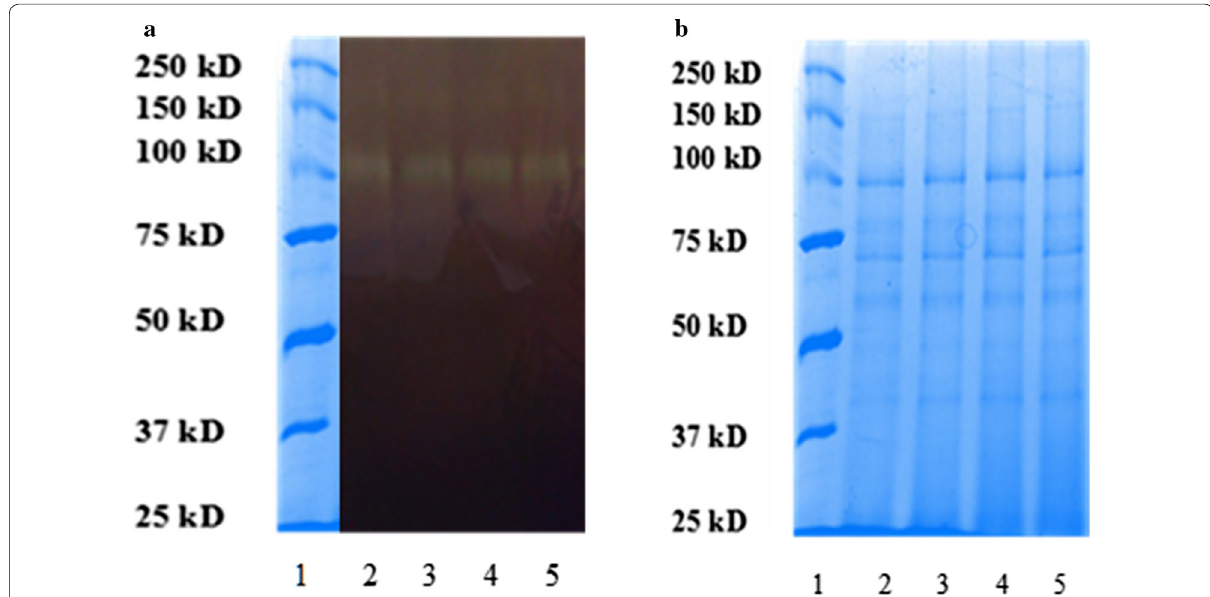
Fig. 3 12% Zymogram and SDS-PAGE analysis of the AMG prepared according to the method described by Martinez et al. (2000). a Lane 1 is precision plus unstained protein standard (BIO-RAD), lanes 2–5 is a crude enzyme of Leohumicola incrustata (iodine staining); b lane 1 is precision plus unstained protein standard (BIO-RAD), lanes 2–5 is SDS-PAGE of crude AMG